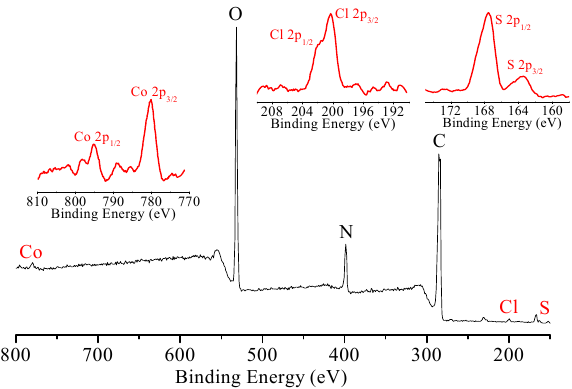
Figure 7. XPS of the cross-section of CoPc@BC after dye adsorption. Left inset: detail of the Co region, middle inset: detail of the Cl region; and right inset: detail of the S region.